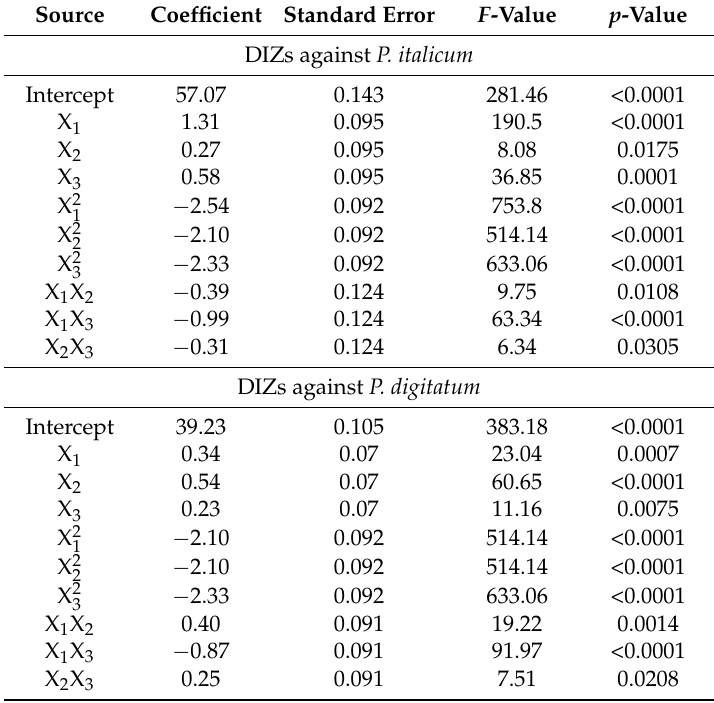
Table 2. Results of regression analysis and corresponding F and p- value of second-order model polynomial regression equation for DIZs against P. italicum and P. digitatum